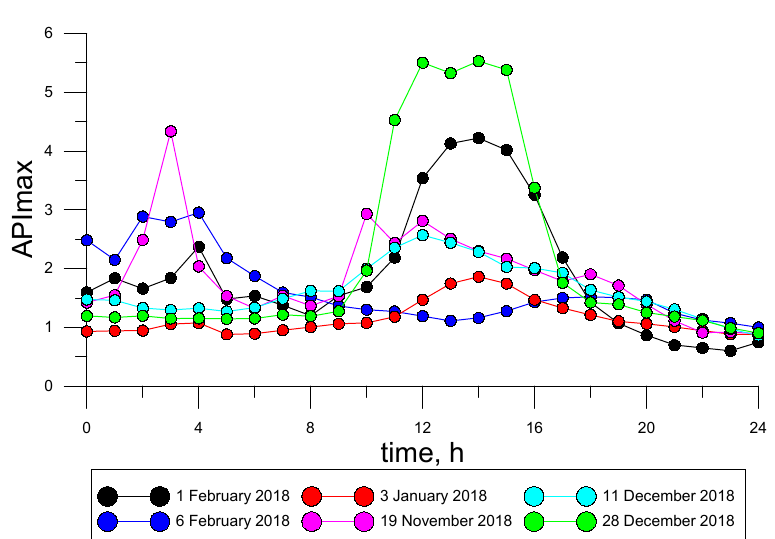
Figure 7. Maximum values of the Air Pollution Index (API) for the selected historical dates for each hour over the territory of 50 × 50 km 2 calculated by the developed CTM model.